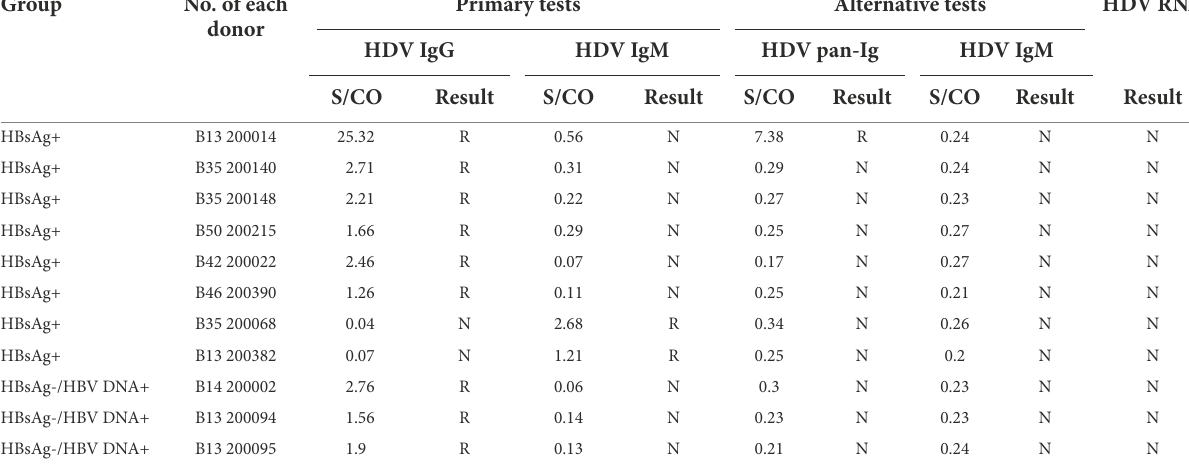
TABLE 2 Results of anti-HDV and HDV RNA of anti-HDV screening-reactive donors.